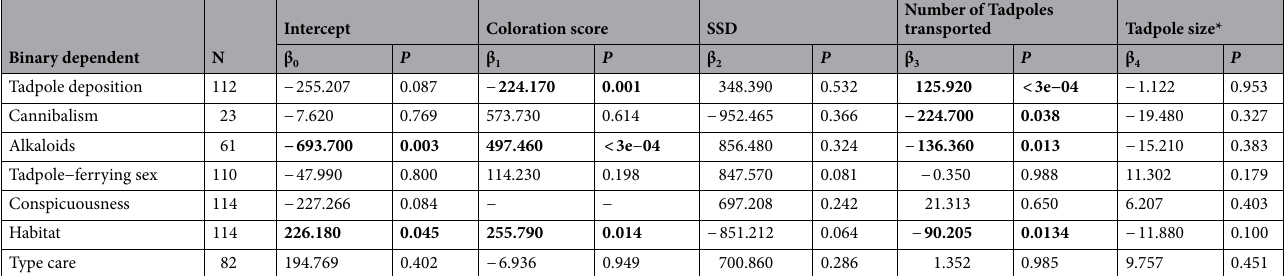
Table 4. Results of the phylogenetic logistic regression for parental care traits and aposematism components in poison frogs. Values in bold denote P < 0.05). The categorical variables and their the character states in parenthesis are: tadpole deposition site (phytotelmata/non-phytotelmata), cannibalism (presence/absence), alkaloids (presence/absence), tadpole-carrying sex (male/female), habitat where adults usually live (near streams/away from streams), conspicuousness (conspicuous/non-conspicuous), and type of care (male/ female). The continuous variables include: Coloration score based on 43 , SSD (sexual size dimorphism), number of tadpoles transported, and size of tadpoles at Gosner stage 25. The asterisk (*) indicates that tadpole size was controlled by female body